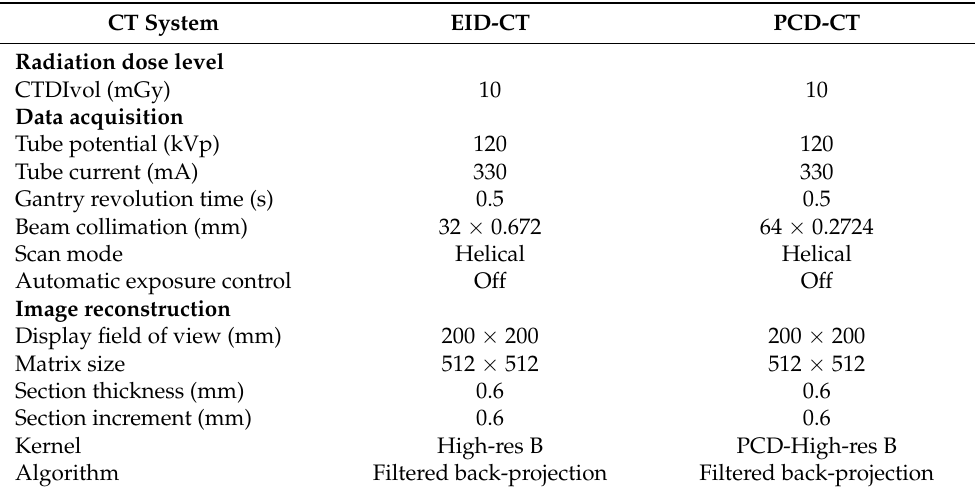
Table 1. Detailed settings for data acquisition and image reconstruction for the investigated CT angiography protocols on both CT